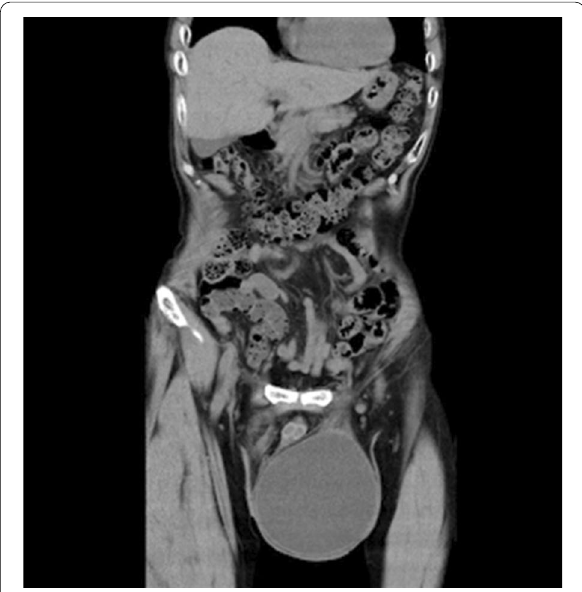
Fig. 3 Computed tomography finding of a postoperative giant scrotal fluid collection (hematocele). Pressure on the urethra due to hematocele is observed